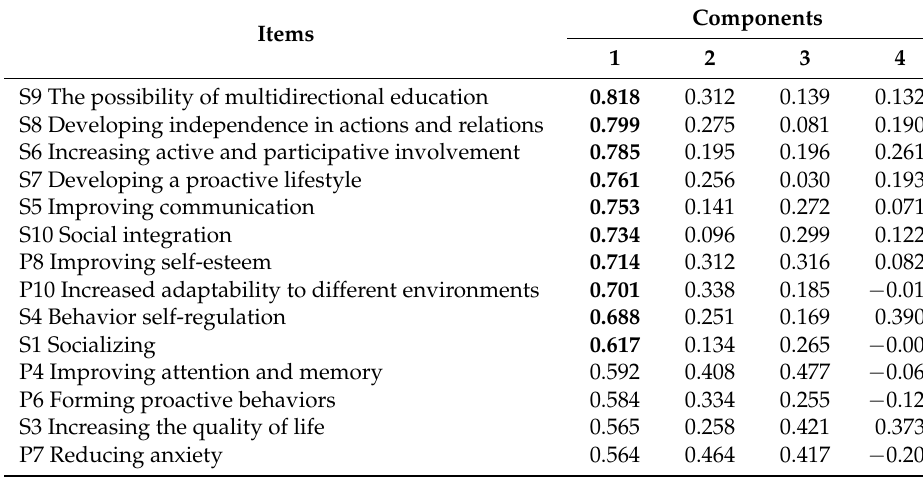
Table 4. Statistical Rotated Component Matrix of the questionnaire of the benefits of figure skating.